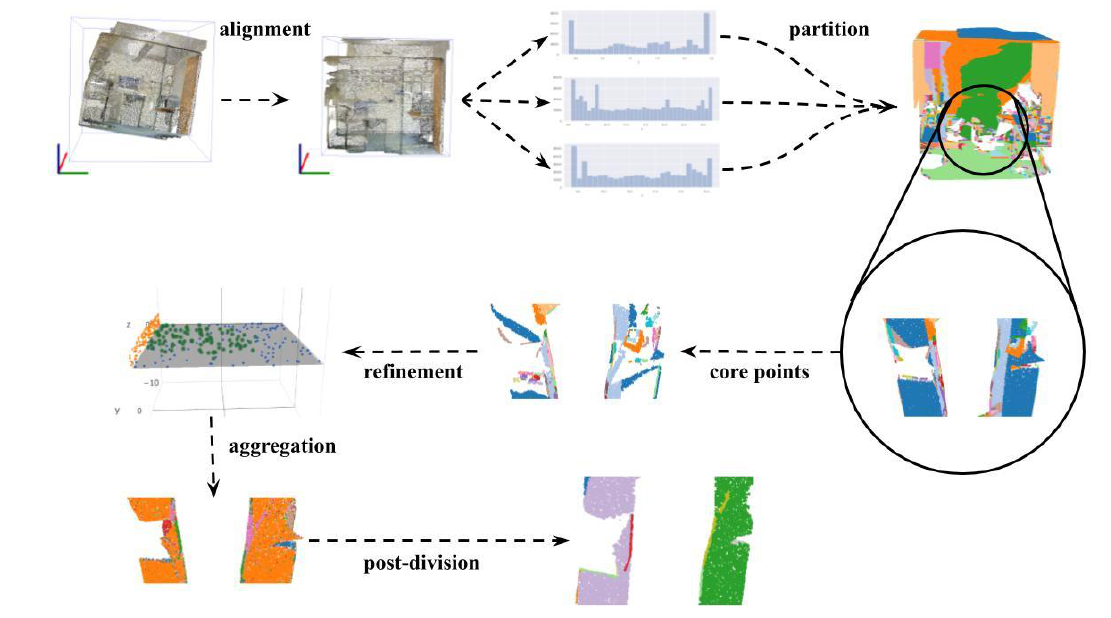
Figure 2. The architecture of the proposed